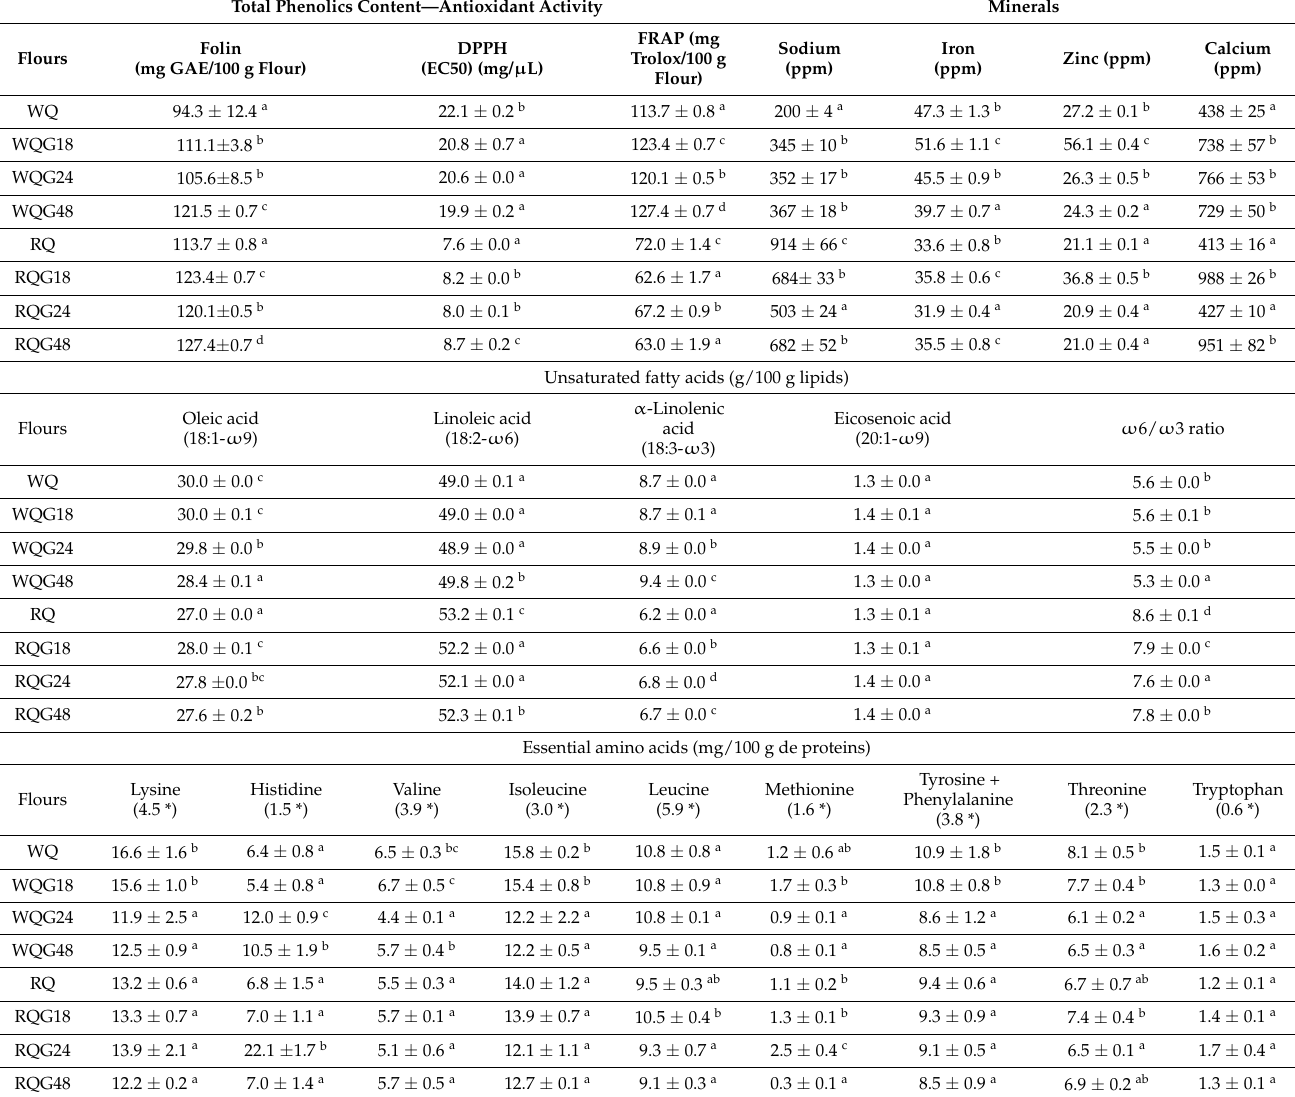
Table 2. Antioxidants, minerals and essential components of ungerminated and sprouted white and red quinoa